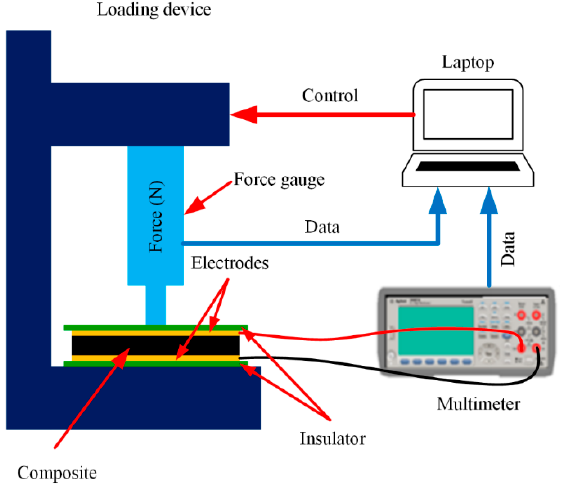
Figure 2. Schematic diagram of the experimental setup.